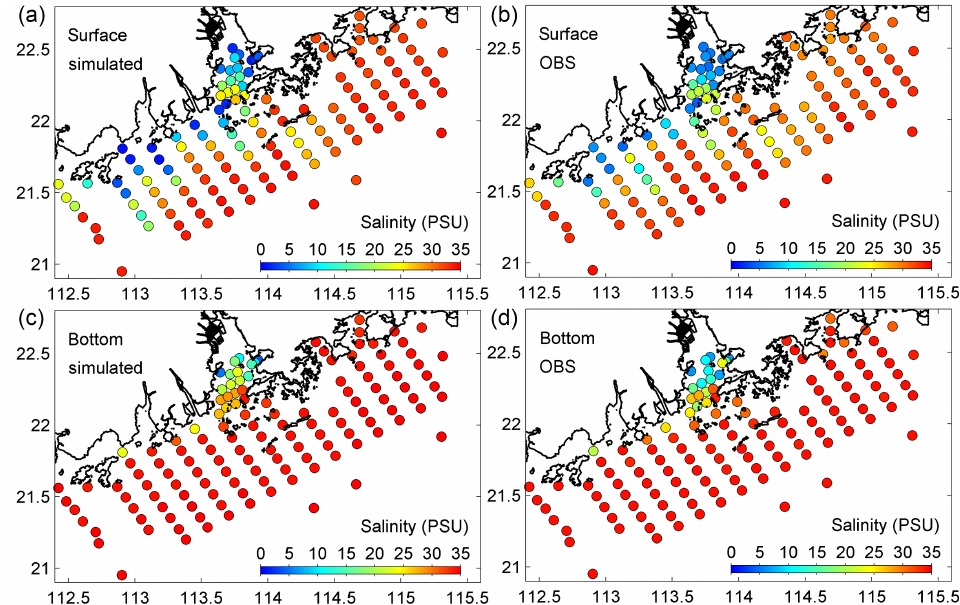
Figure 5. Comparisons of the simulated (left panels) and the observed (right panels) salinity at the surface layer (upper panels) and the bottom layer (lower panels) during July and August 2006.